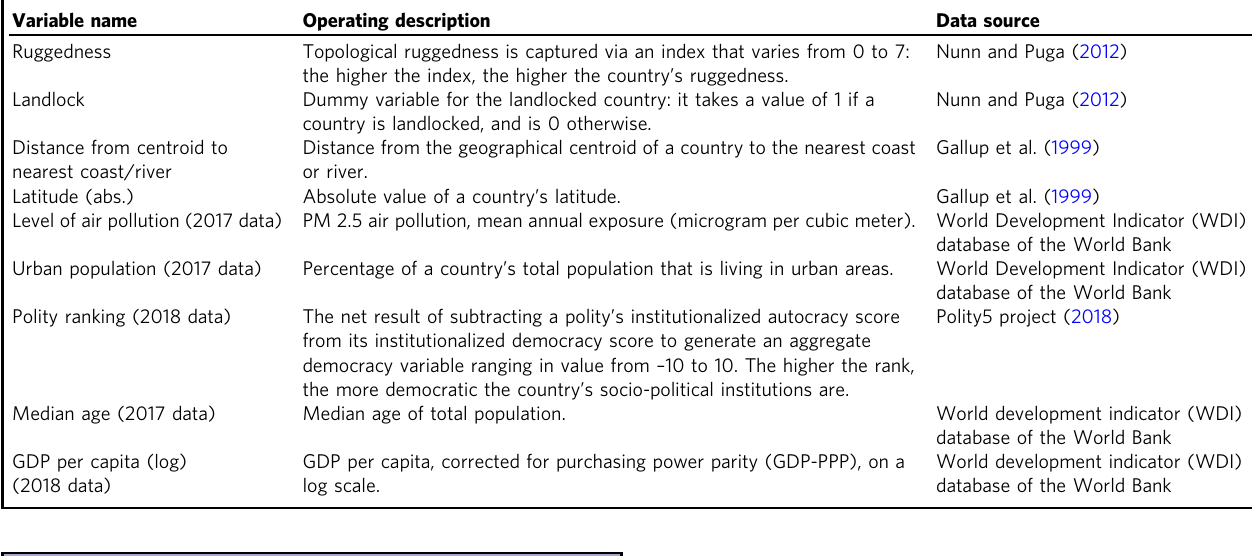
Table 2 Descriptive statistics pertaining to the dependent, explanatory and control variables.